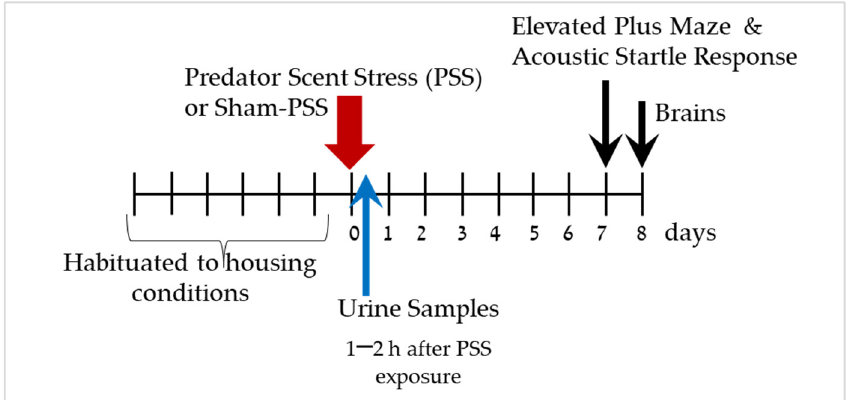
Figure 1. Study design—The effect of predator scent-stress (PSS) on corticosterone levels and behavioral responses. After habituation period of seven days, animals were exposure to PSS or sham-PSS for 15 min. Urine samples were collected 1–2 h after PSS exposure for corticosterone levels. Behaviors were assessed on day 7 using the elevated plus maze (EPM) and the acoustic startle response (ASR) assay. On day 8, rats were sacrificed, and their brains were collected for immunoreactivity analyses of Iba-1 and CRXCR1 in the hippocampus